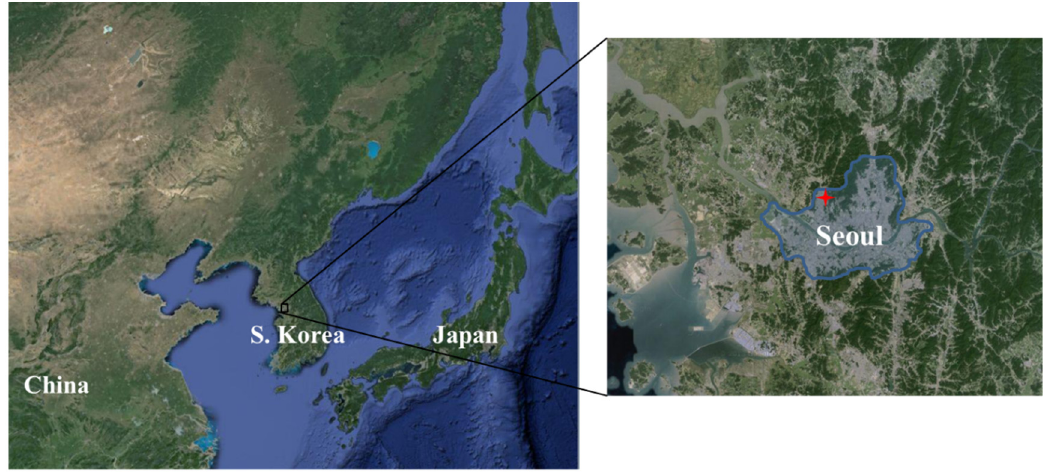
Figure 1. Sampling sites within the intensive observation site in Seoul, Korea.